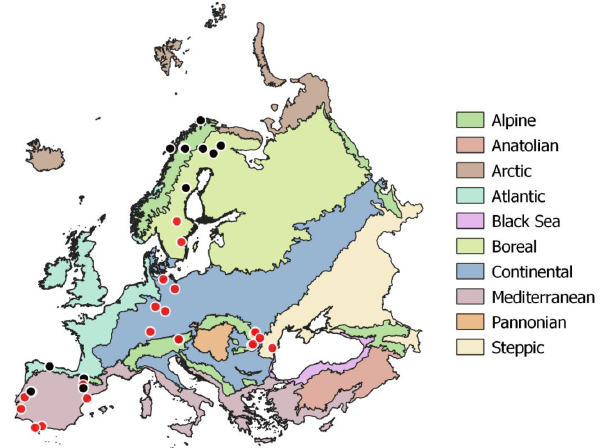
Figure 2. Sampling sites across European biogeographical regions. Red circles symbolize sampling sites including three land use types (woodland, grassland, cropland). Map of European biogeographical regions was obtained from biogeographical regions data set of the European Environment